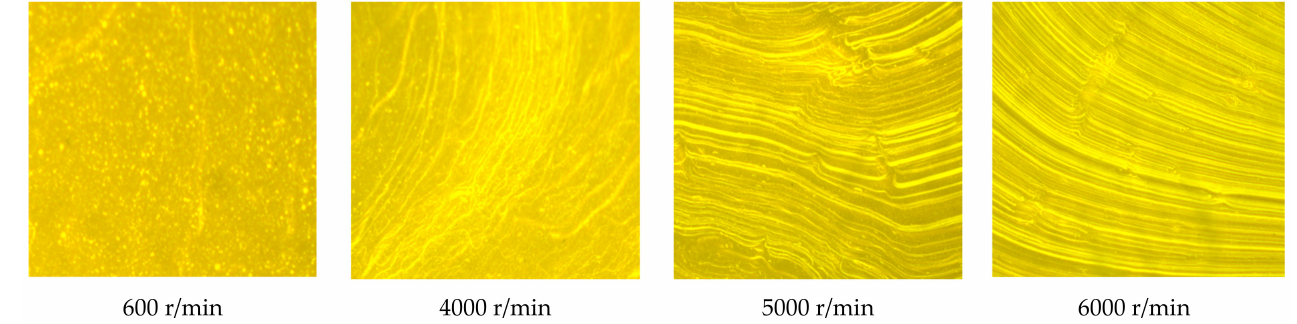
Figure 3. Fluorescence microscopy test of SBS-modified asphalt of different shear rates (100 times). The SBS phase morphology changed from droplet (600 r/min without network struc- ture) to the filament (4000 r/min with network structure) with an increasing shear rate. The